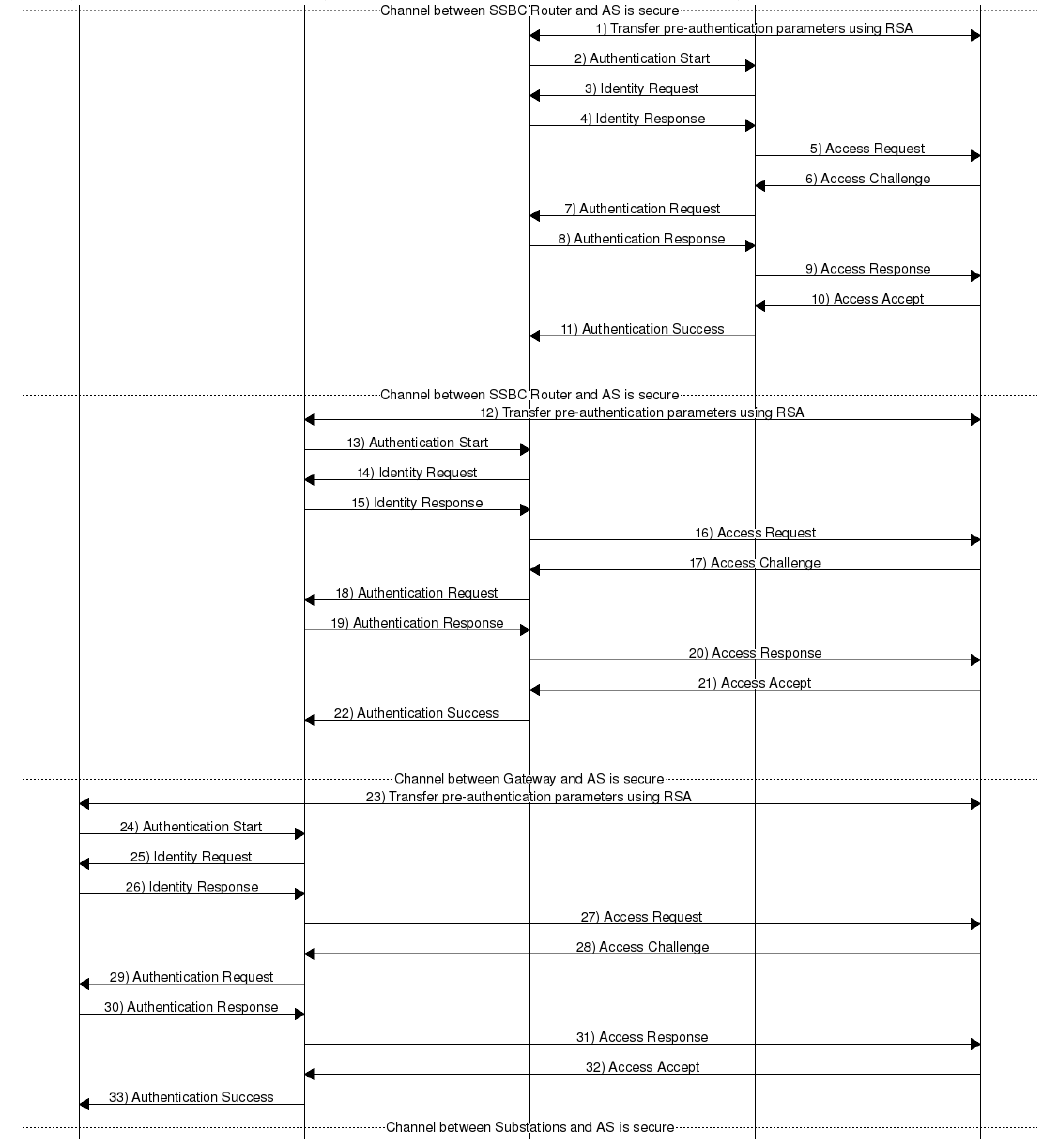
Figure 4. Node Authentication Sequence